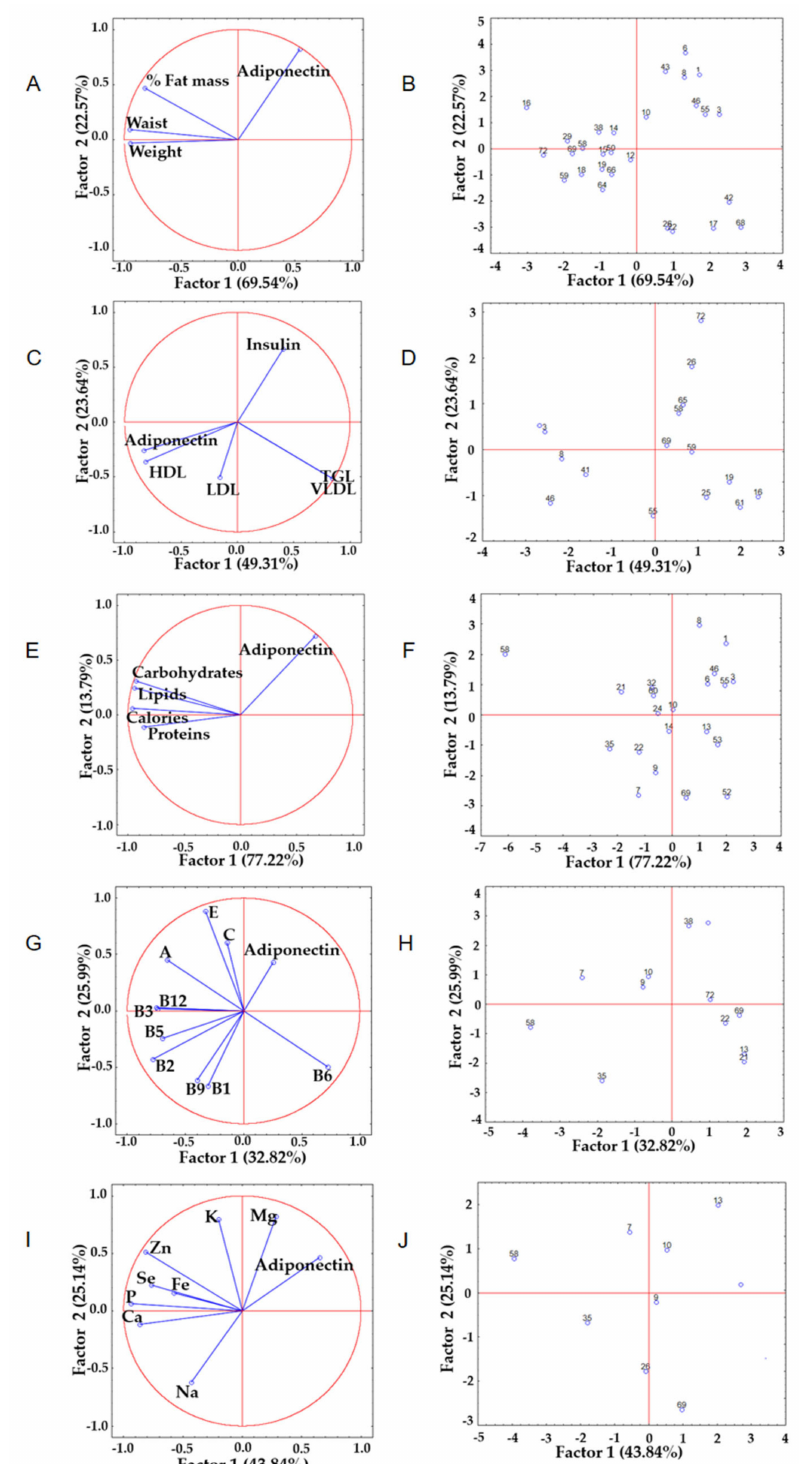
Figure 4. Principal component analysis (subgroup). Left column: relationship between adiponectin and anthropometric parameters ( A ), biochemical parameters ( C ), caloric and macronutrient intake ( E ), vitamin intake ( G ), and mineral intake ( I ). Right column: distribution of pattern similarities among subjects away from the initial set: anthropometric parameters ( B ), biochemical parameters ( D ), caloric and macronutrient intake ( F ), vitamin intake ( H ), and mineral intake ( J